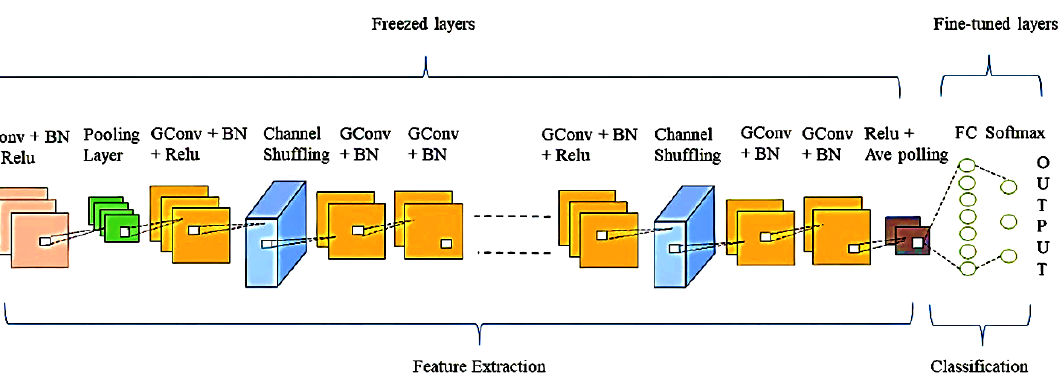
Figure 2. ShuffleNet convolution neural network architecture of the proposed framework, the GConv represents group convolutions.